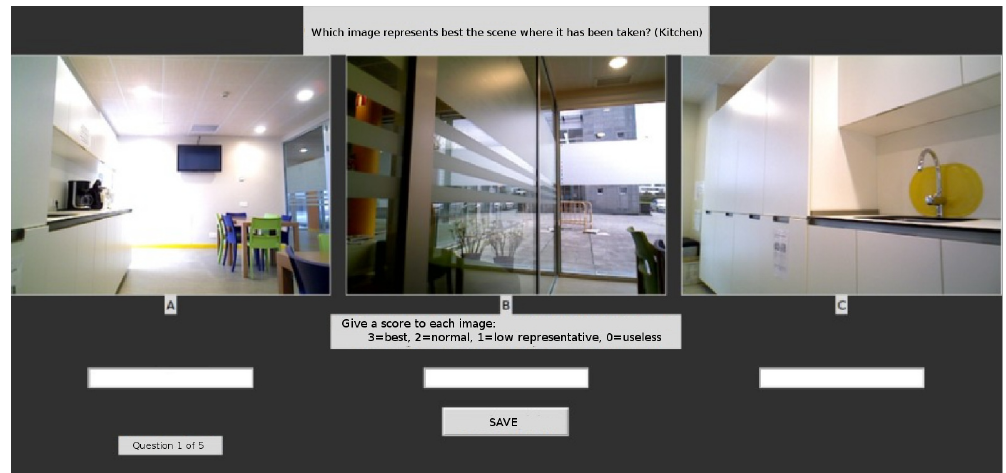
Figure 6. Snapshot of the screen taken during the performance of the second experiment, while taking a poll.